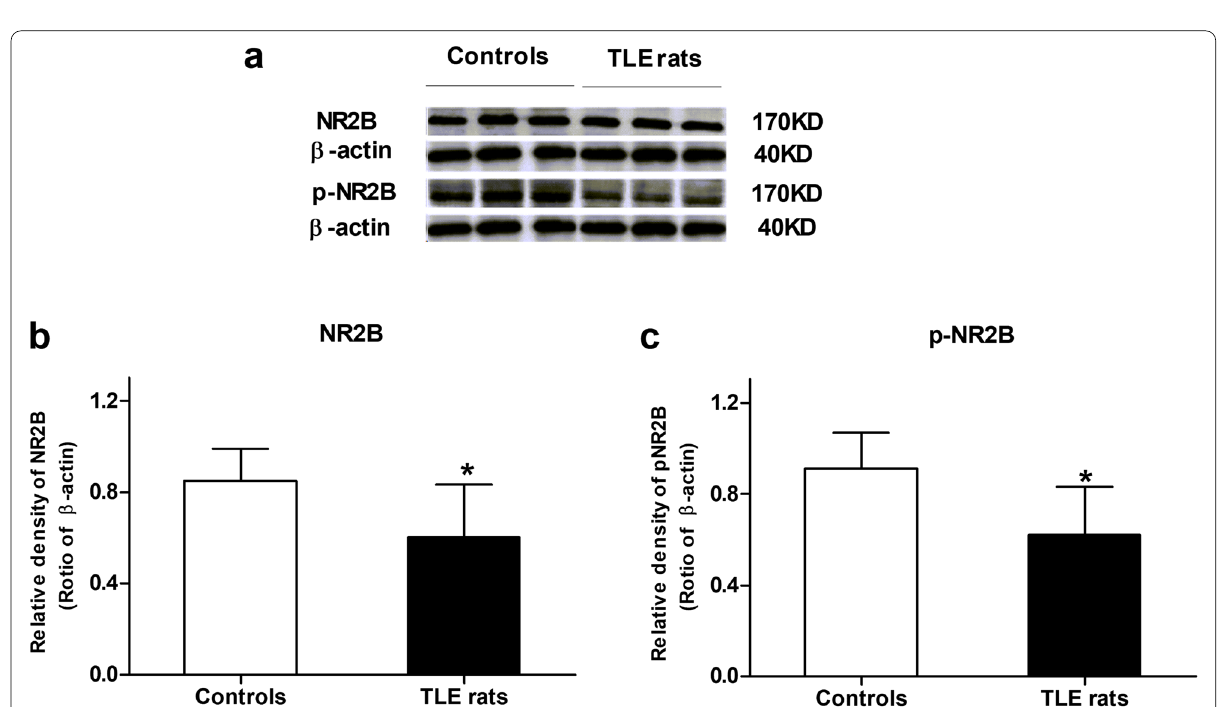
Fig. 2 Expression of hippocampal NR2B-containing NMDA receptors in rats. a Western blot results showed decreased protein levels of NR2B and p-NR2B in TLE rats ( b and c ). Quantification of bands in A. n 3 in each group. * P < 0.05 vs =